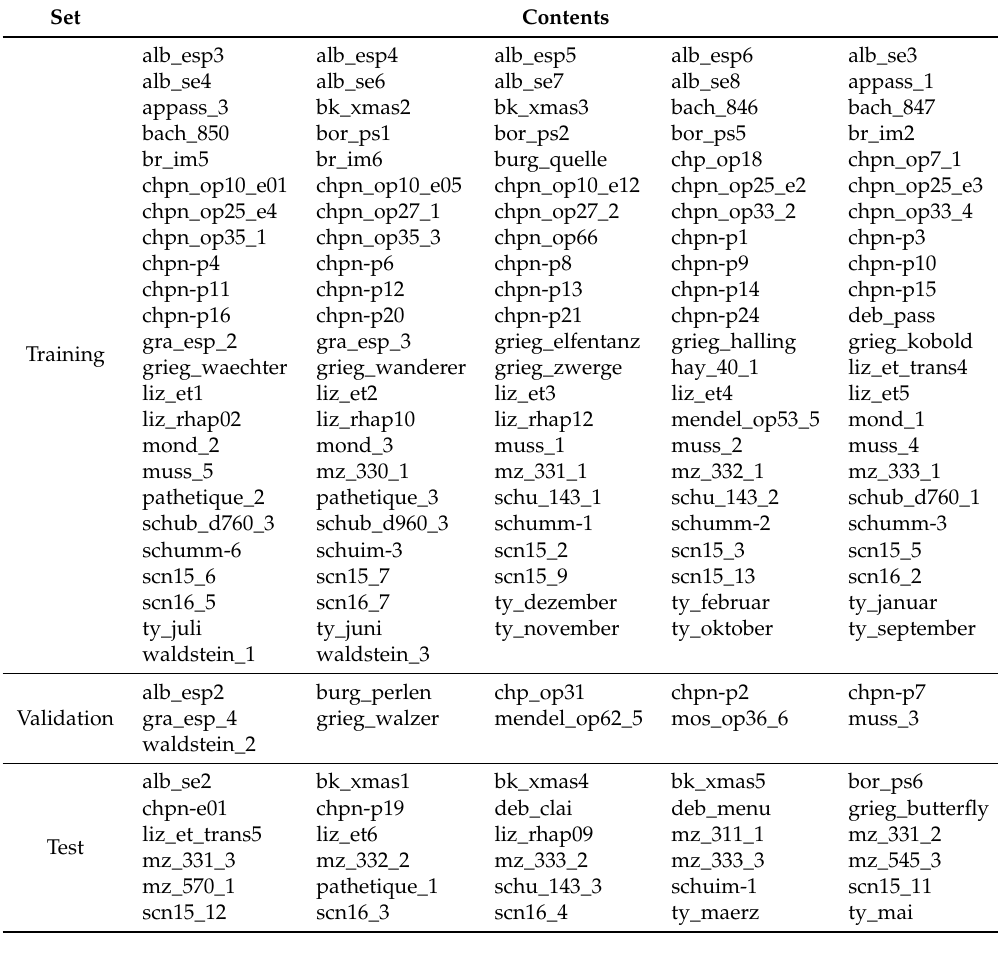
Table A1. Details for data partitions of the MAPS